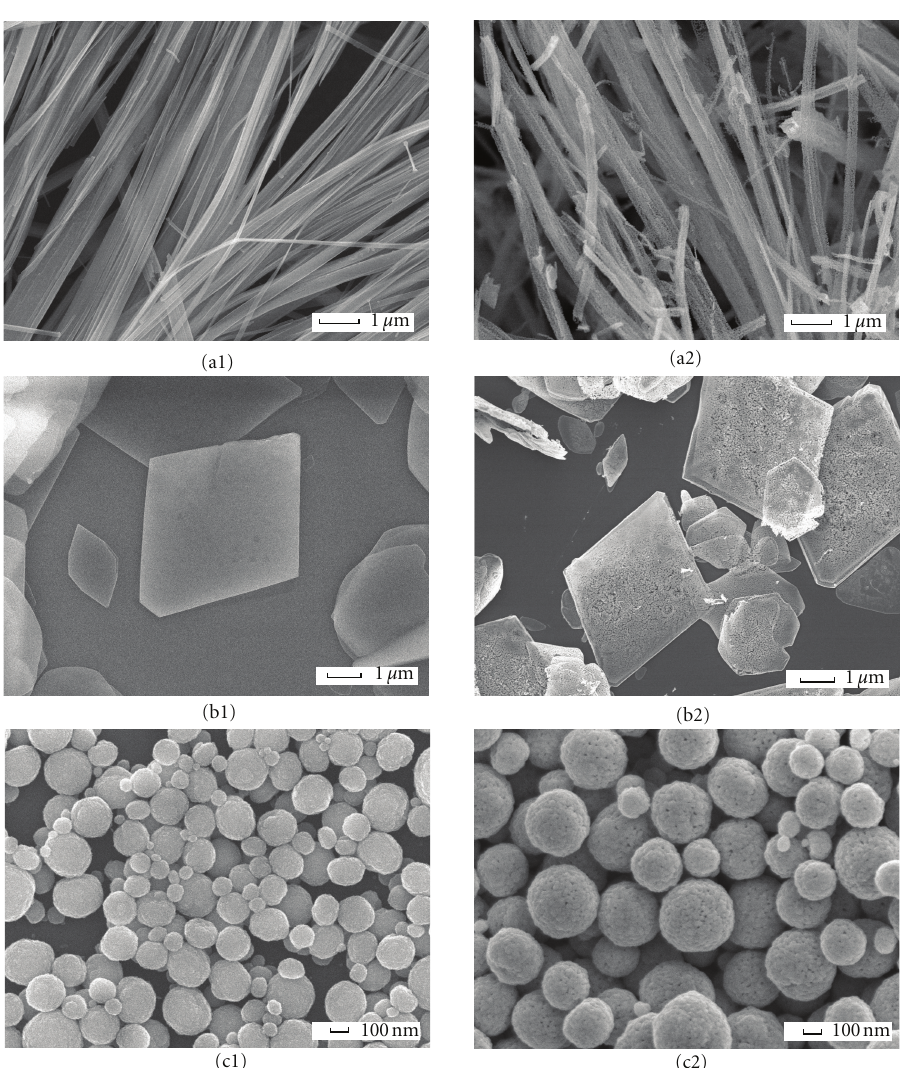
Figure 2: Various surface morphologies of synthesized ZnO: (a1), (b1), and (c1) ZnO gel solutions dried at 160 ◦ C; (a2), (b2), and (c2) samples calcinated at 500 ◦